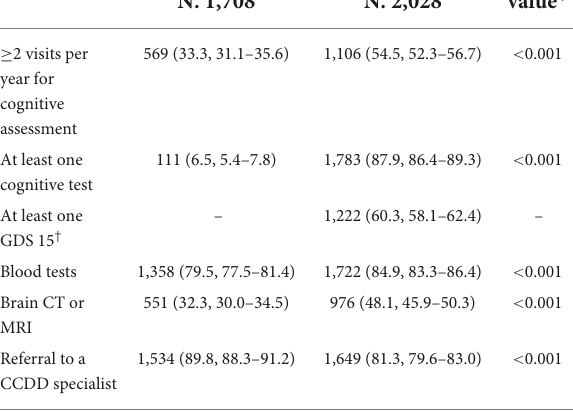
TABLE 2 Number (%, 95% CI) of patients prescribed diagnostic tests in primary care and referral to a CCDD specialist for cognitive decline, in the pre- and post-intervention.